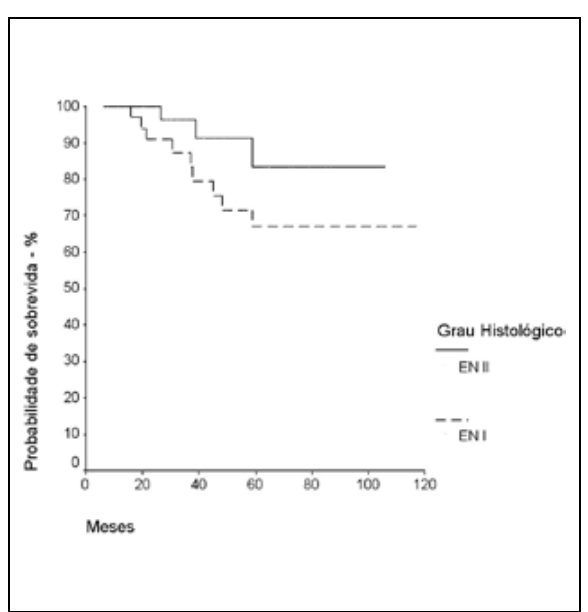
observaram uma sobrevida livre de doença menor em pa- cientes portadores de LH EN II, em um estudo que incluiu pacientes tratados com diversas modalidades terapêuticas durante as décadas de 70 e 80. Portanto, pode ter